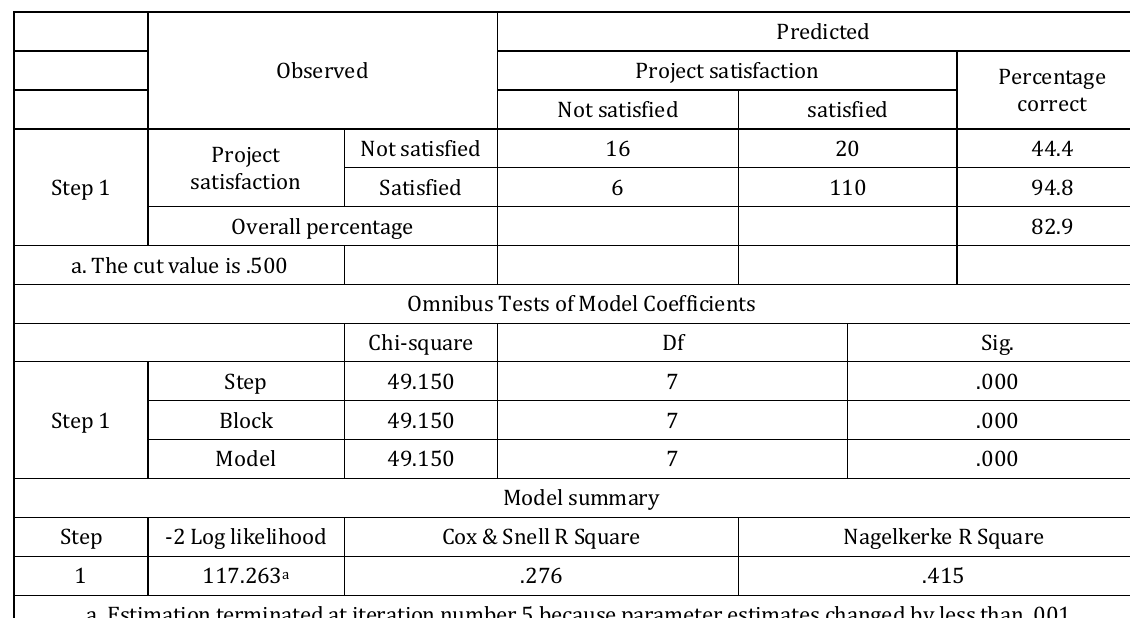
Table 8. Binary Logistics Regression